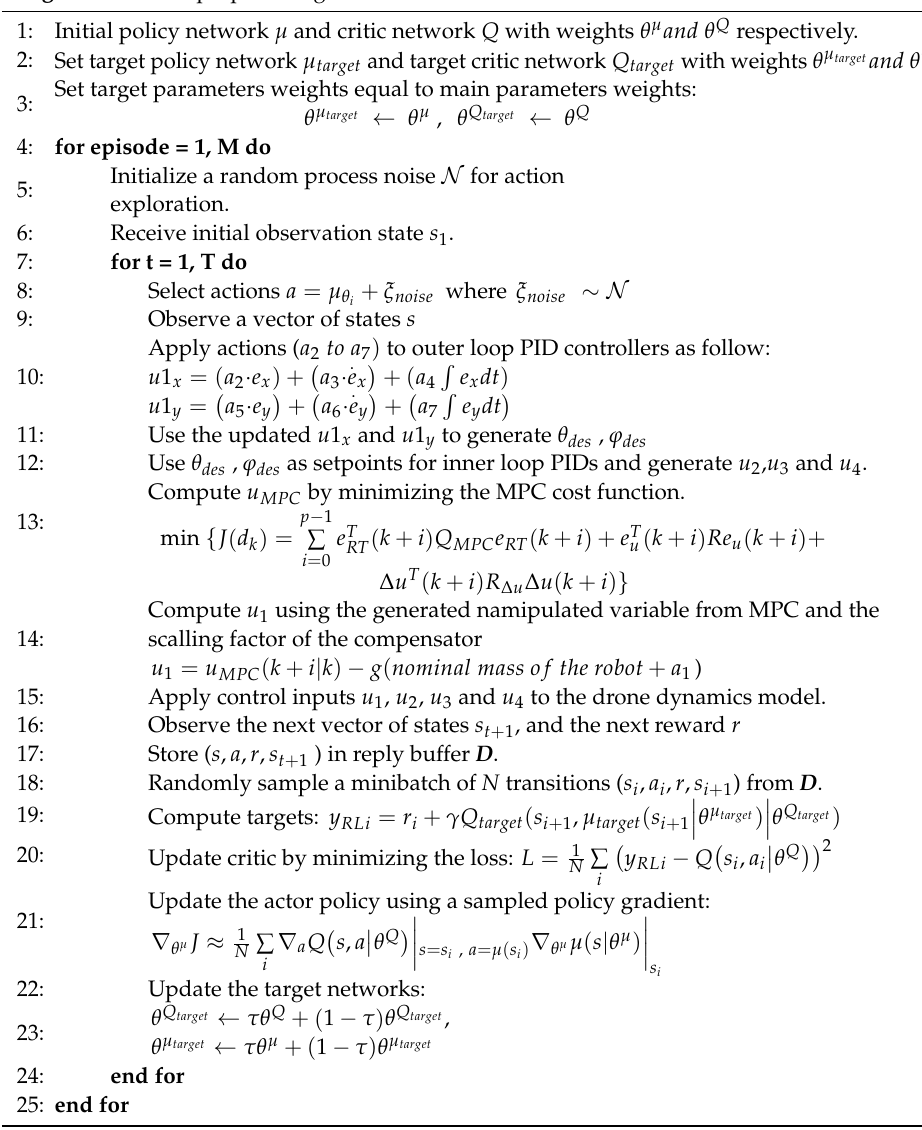
Algorithm 1. The proposed